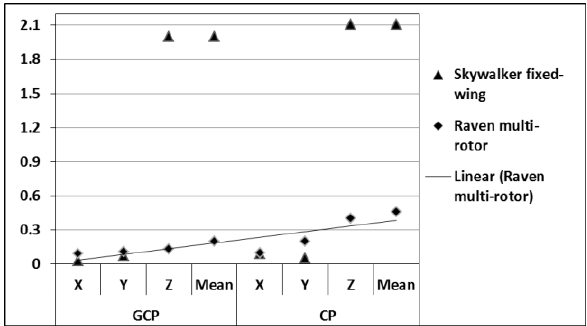
Figure 6. Graph of the RMSE (m) for the GCPs and CPs